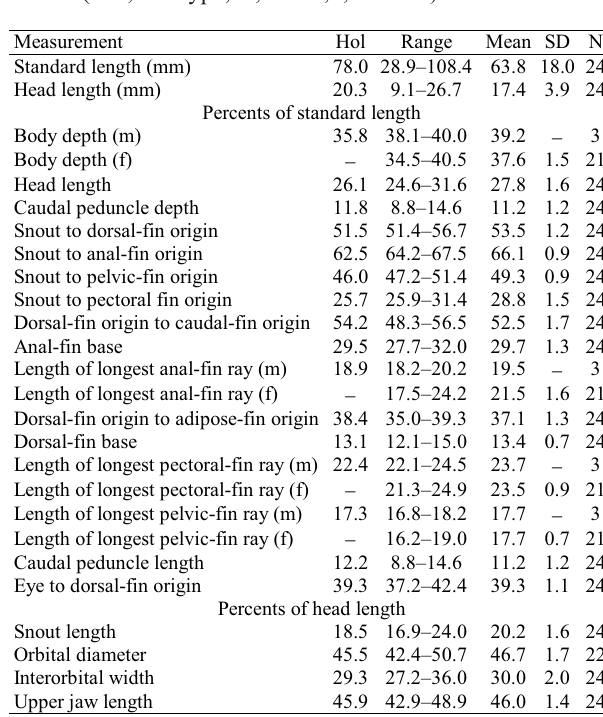
Etymology . The specific name henseli is in homage to R. Hensel for his contributions to Ichthyology in Southern Brazil. Material e xamined: All specimens from Rio Grande do Sul, Bra-